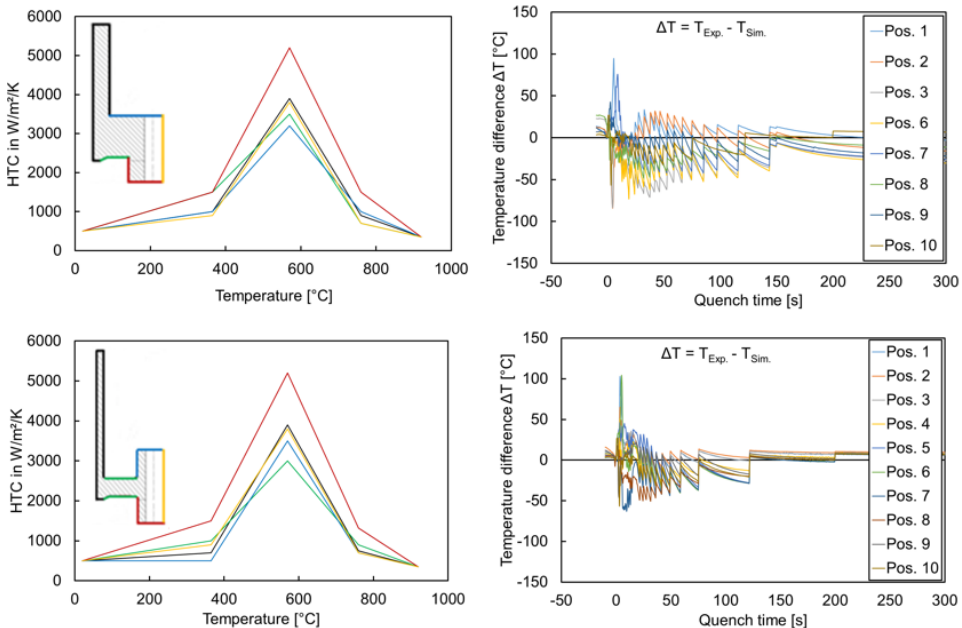
Figure 6. Adjusted HTC and local temperature differences between the measured and calculated temperature curves during transport and oil quenching for geometry types G1 ( top ) and G4 ( bottom ) [23].